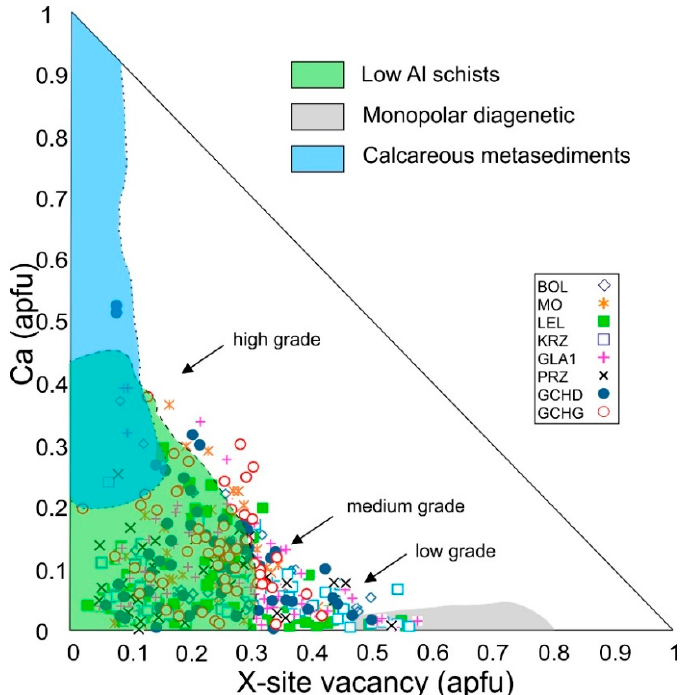
Figure 9. X-site vacancy vs. Ca diagram of Henry and Dutrow [91] used for discrimination of tourmaline grown in low Al schist, calcareous metasediment, and during diagenesis in sedimentary rocks (monopolar diagenetic tourmaline). Points on the diagram reflect mineral chemistry of the examined tourmaline grains.